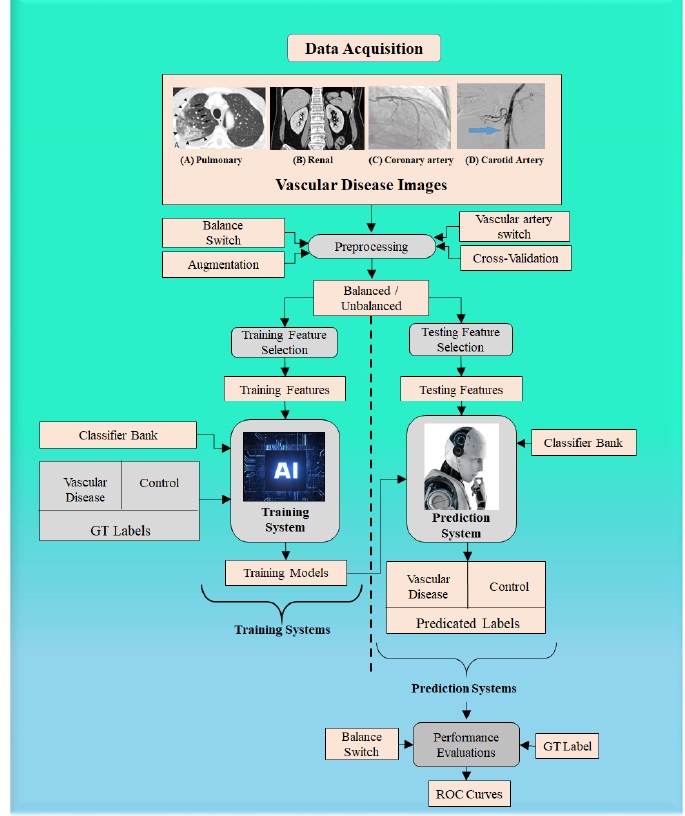
Figure 13. Machine learning model to predict vascular disease.